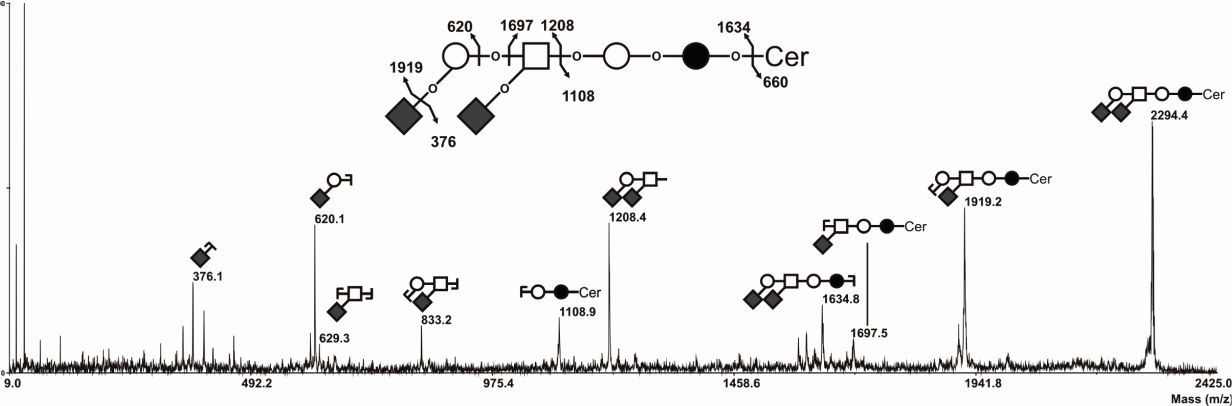
Figure 5. MS/MS sequencing of permethylated G D1 at m / z 2295 with ceramide moieties d18:1/C24:0 (Cer**). All fragments are observed as [M+Na] + adducts. Fragment ions were annotated according to nomenclature of Domon and Costello [26]. The nature